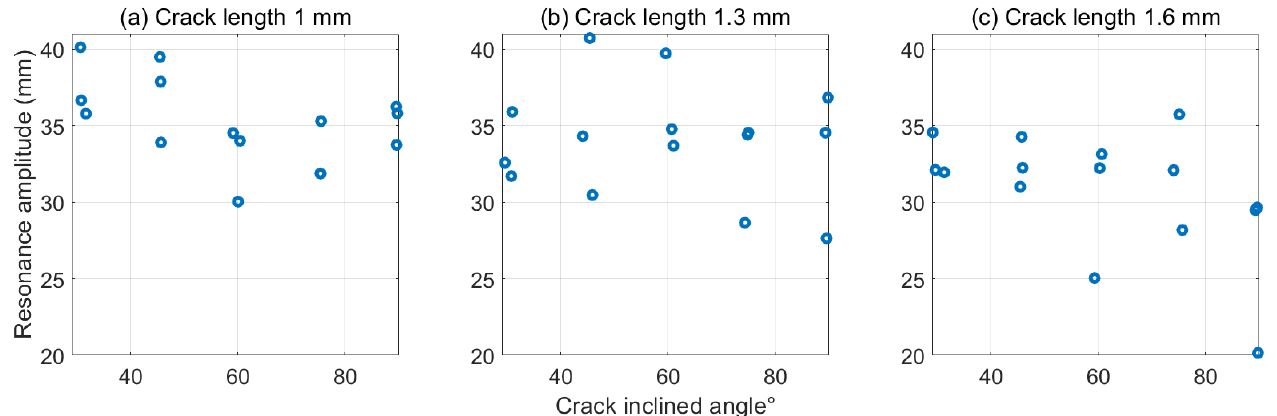
Figure 9. First-order resonance amplitude for inclined cracks with different angles. ( a ) 1 mm crack length. ( b ) 1.3 mm crack length. ( c ) 1.6 mm crack length.